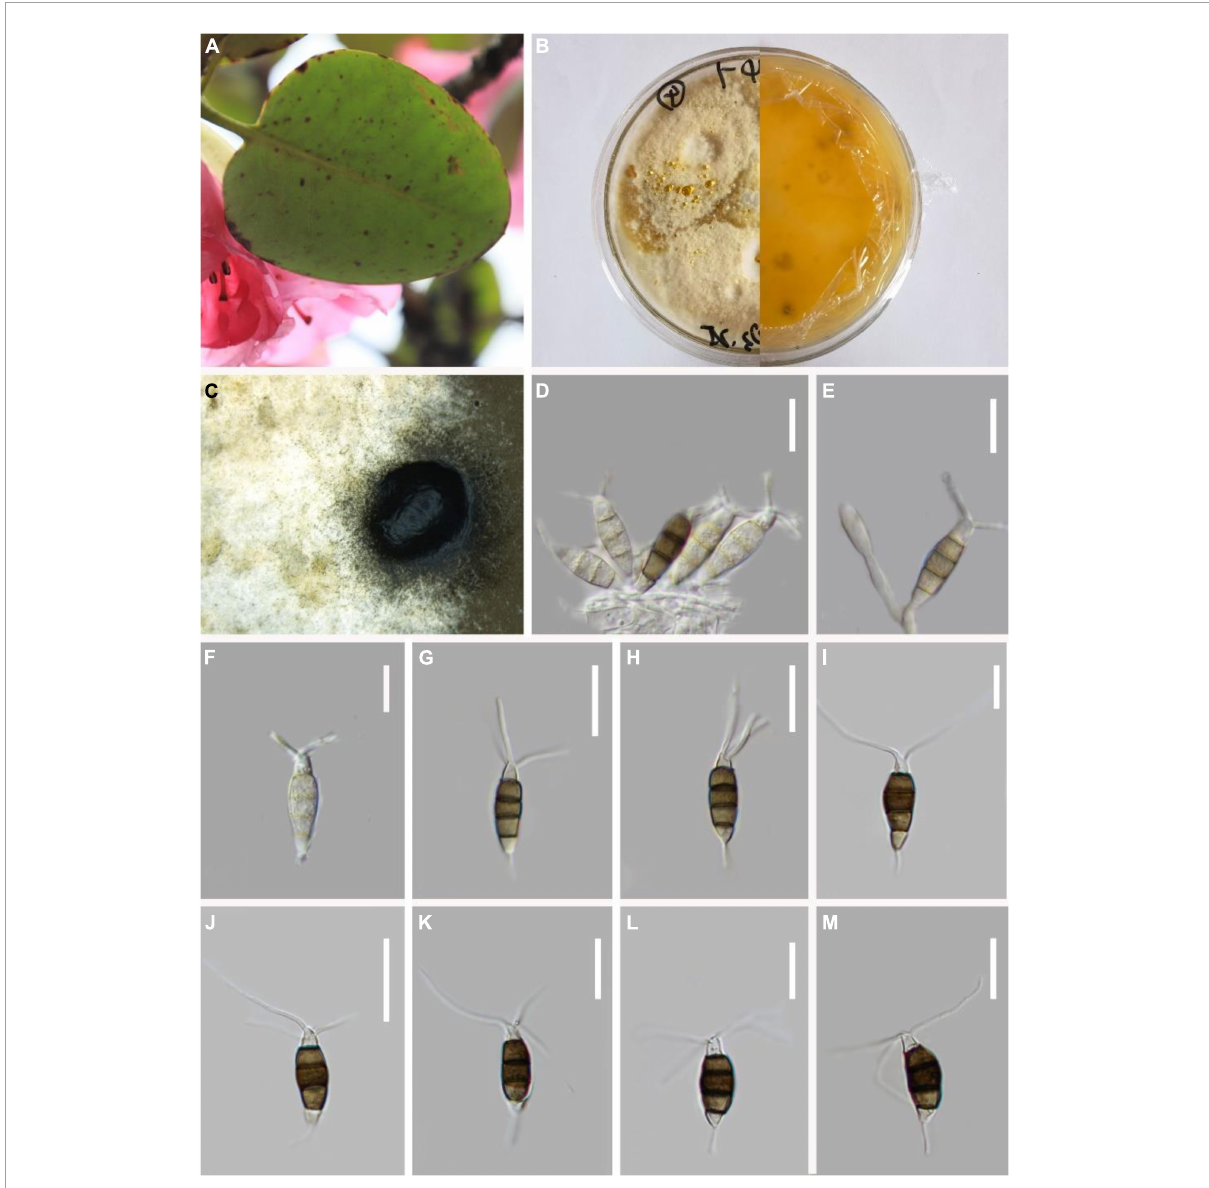
FIGURE8 Pestalotiopsis trachicarpicola (KUN-HKAS 124577). (A) Leaves of Rhododendron cyanocarpum . (B) Culture on potato dextrose agar (PDA) (upper and lower view). (C) Conidiomata on PDA. (D,E) Conidiophores, conidiogenous cells, and conidia. (F–M) Conidia. Scale bars: (D–M) 10 µ